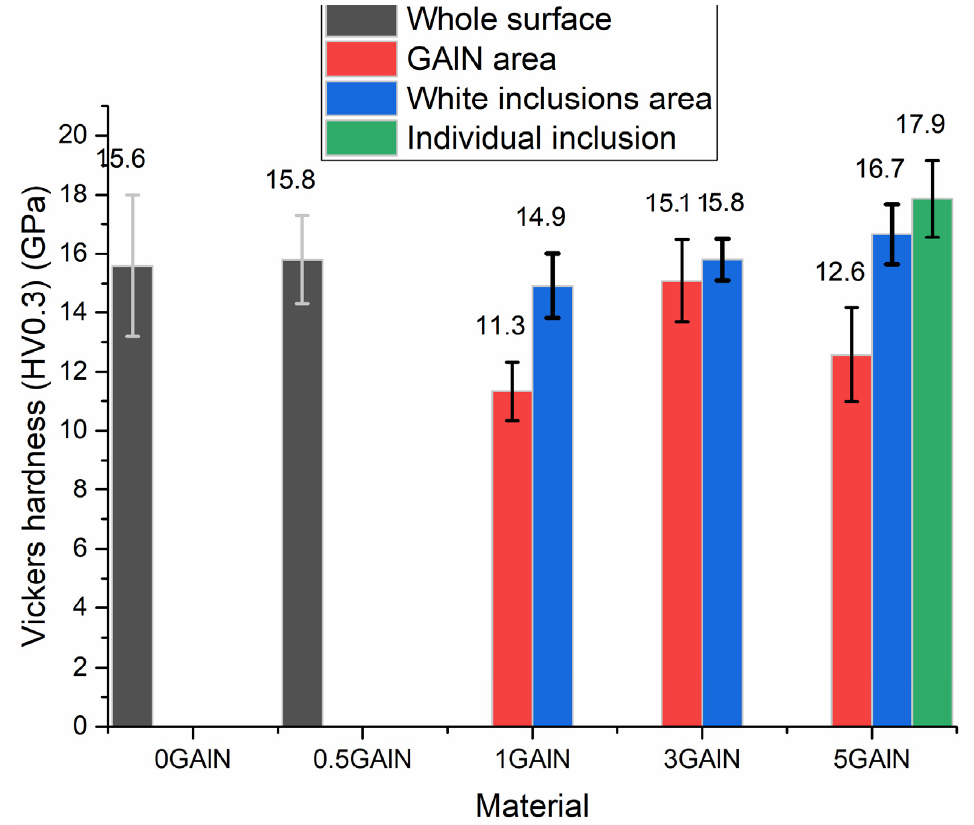
Figure 11. Vickers microhardness testing results, obtained for SPS-ed 0 GAlN ceramics and compo- sites.